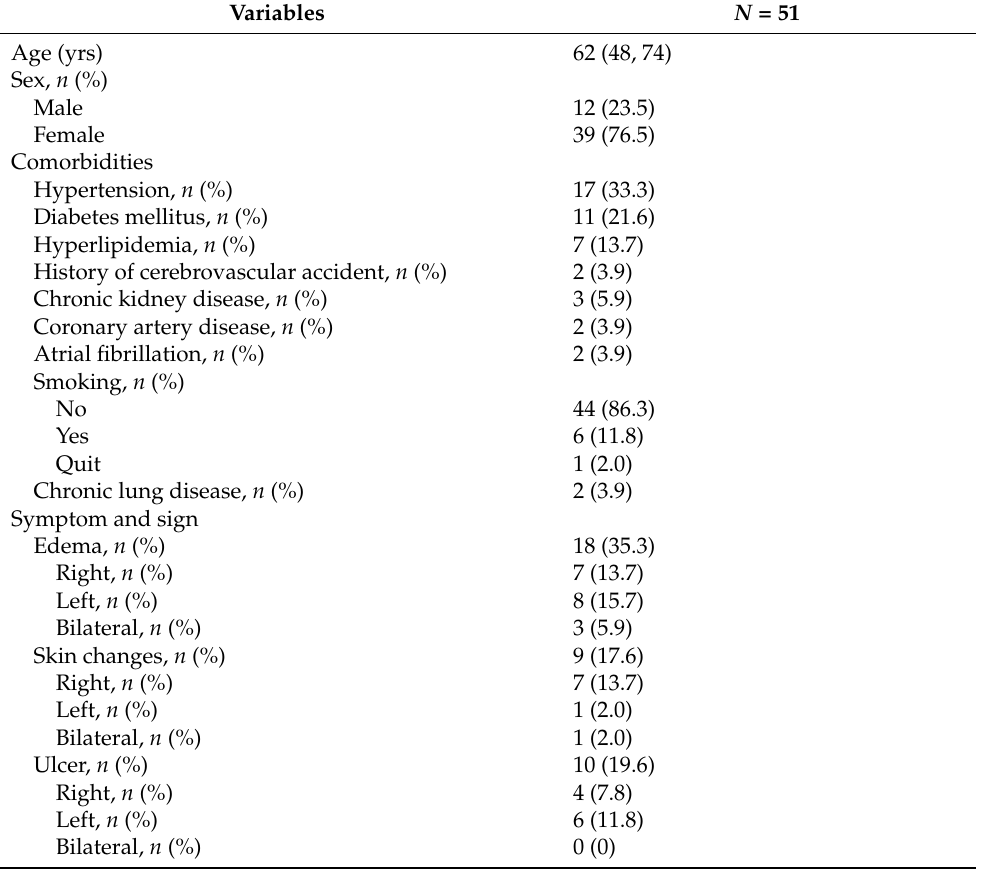
Table 1. Baseline demographics and clinical characteristics of all patients who underwent magnetic resonance imaging.